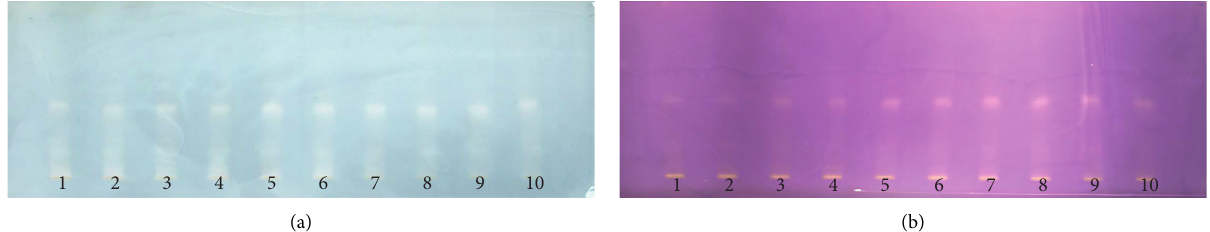
Figure 7: The free radical scavenging activity: (a) after dipping in ABTS ∗ + solution and (b) after dipping in DPPH _ solution; spot volumes 5 μ L.